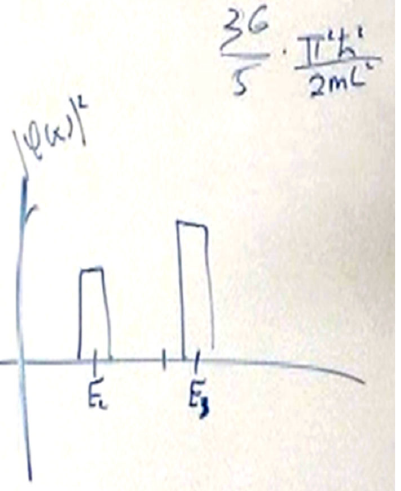
FIG. 5. A histogram Wayne drew to describe the expectation value of energy. He labeled the vertical axis using a square of a function. On the horizontal axis he labeled E 2 and E 3 and plotted the probabilities. He then drew a tick mark closer to E 3 because there is a higher probability of measuring E 3